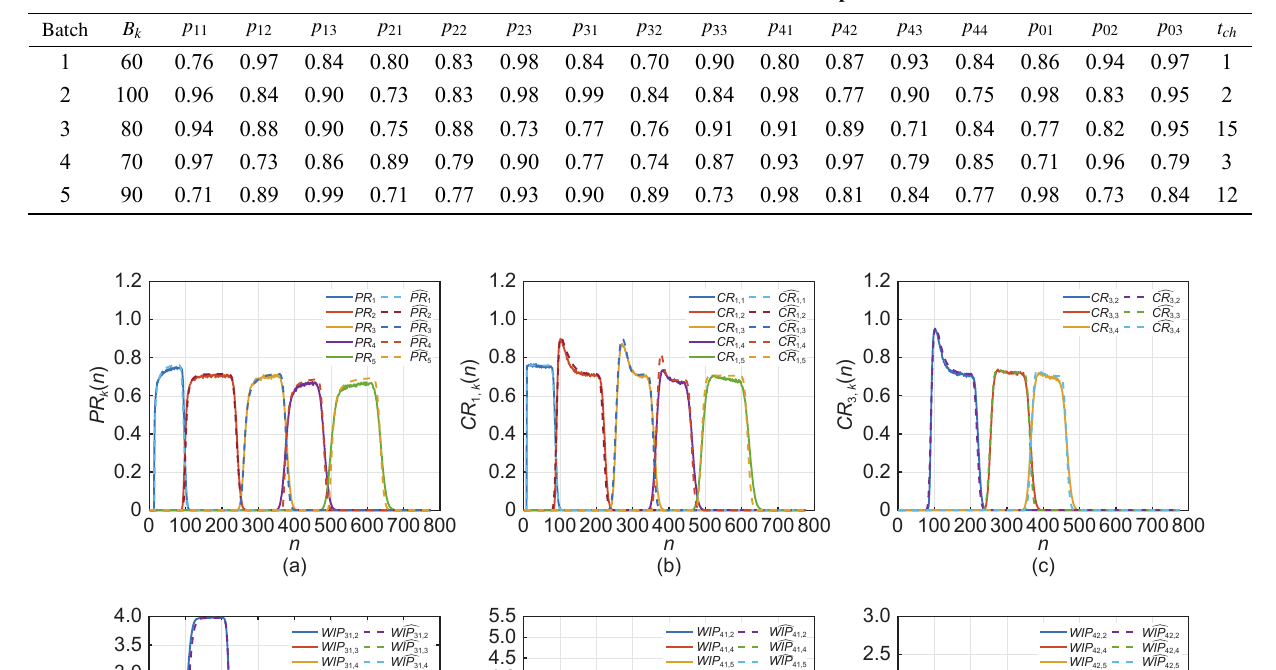
Table 3 Parameters of the illustrative example.